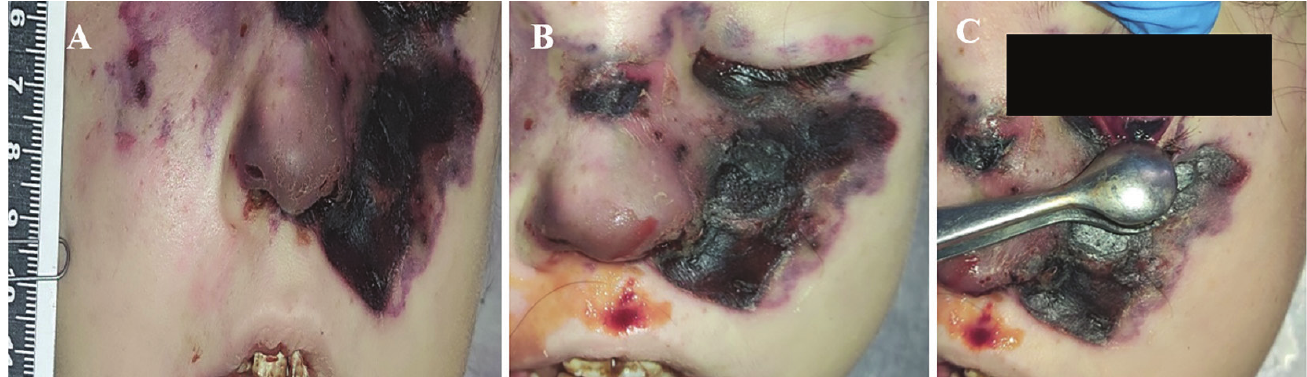
Figure 1 - Fungal lesion region with facial disfigurement: A, Necrosis of the skin and subcutaneous tissue in the form of a black scab from the nasal cavity area. B, Necrosis of the skin of the bridge of the nose, zygomatic region and eyelids of the eye socket. C, Necrosis of skin and mucous membrane of eyelid and sclera in the form of black scab.